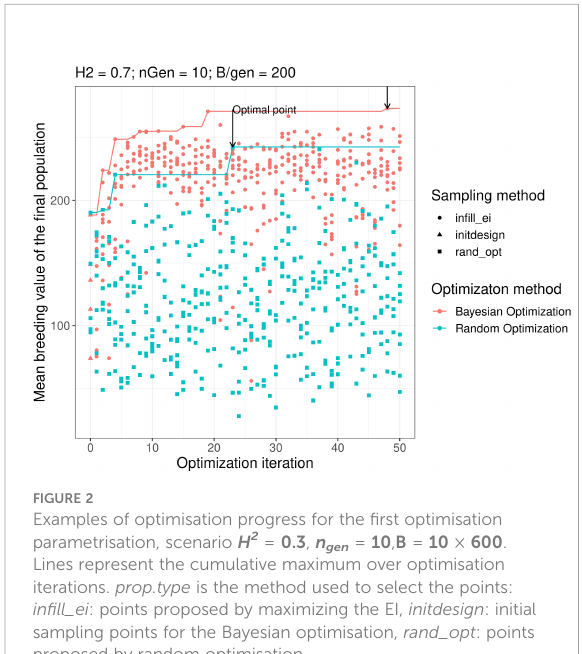
FIGURE 2 Examples of optimisation progress for the fi rst